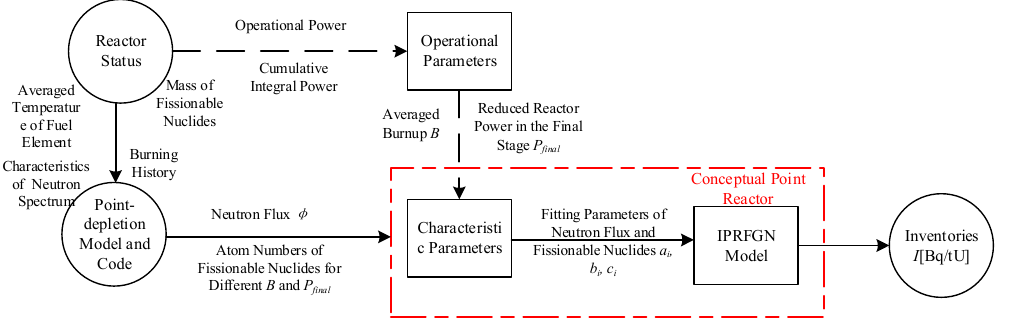
Figure 2. Calculation flow of the IPRFGN model.